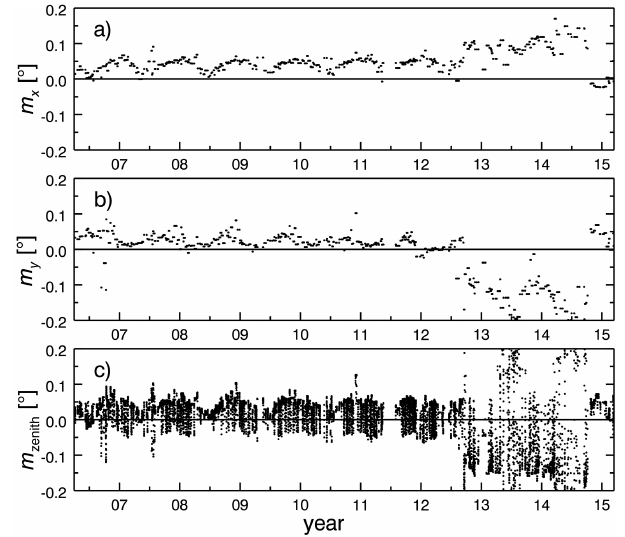
Figure 7. Mispointing results determined from Zugspitze measure- ments. (a) x component of mispointing in spectrometer coordi- nates. (b) y component of mispointing in spectrometer coordinates. (c) Zenith component of mispointing in sky